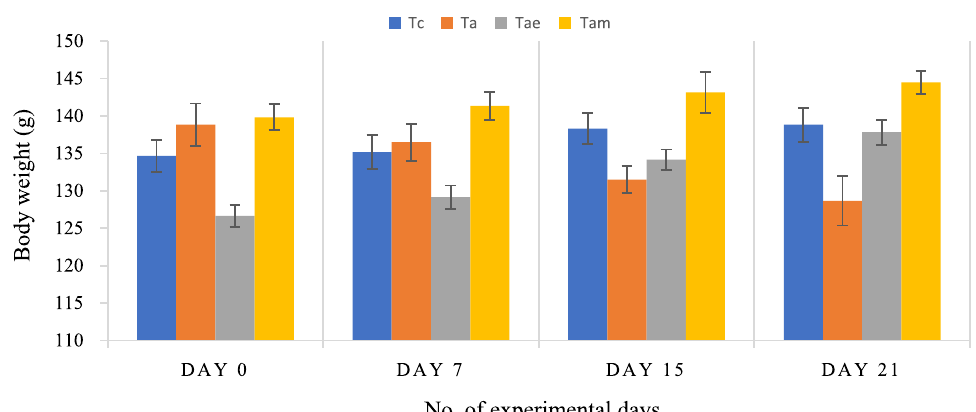
Fig. 1 Effect of mango peel extract and mangiferin on body weight in the alloxan-induced type I diabetic rat. There was a significant decline in body weight in all alloxan-induced type I diabetic rats compared to the control group within 21 days. Tc, Tae and Tam were shown to increase in body weight with regular interval of